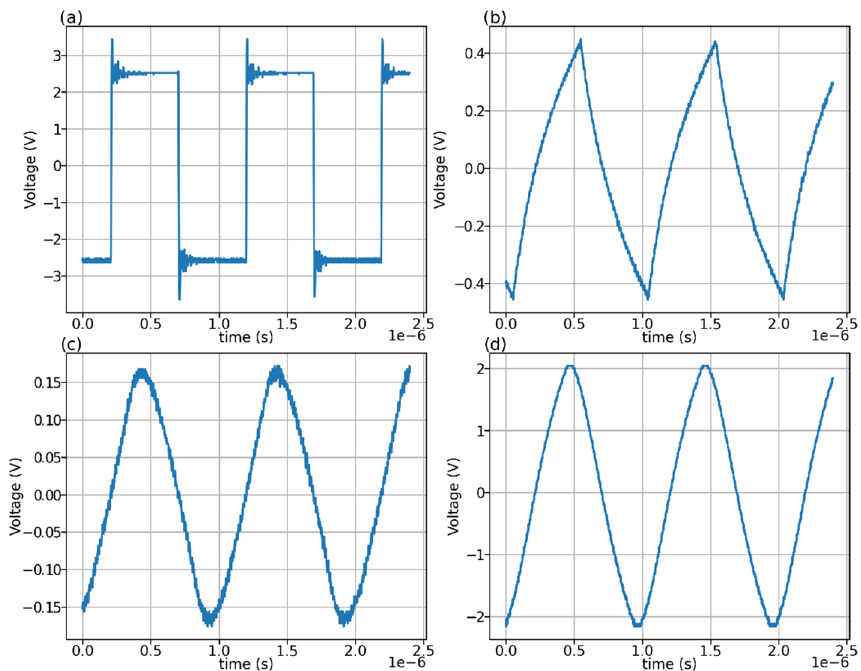
Figure 4. Measured waveforms for Doppler signal generation subsystem. All waveforms recorded with AC coupling at 1 GSa/s. ( a ) MAX7375 output. ( b ) First low-pass filter output. ( c ) Second low-pass filter output. ( d ) Ultrasonic emitter drive signal.